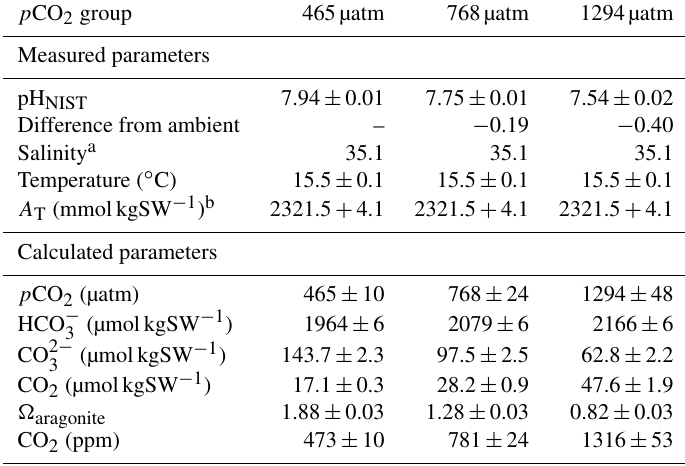
Table 1. Measured and calculated water parameters for three different p CO 2 groups (µatm) given as mean and standard deviation. Carbon chemistry values were computed based on daily measurements (0–14 days) of pH NIST in all replicates ( n = 4), means of hourly temperature measurements in three tanks ( n = 336), and mean salinity and total alkalinity based on two analyses per treatment at the start and end date ( n = 6) in seawater running into the